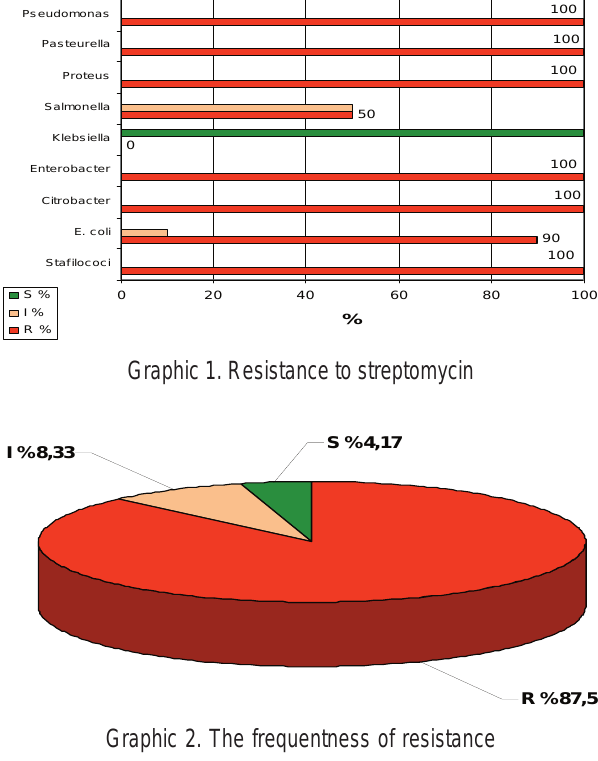
Graphic 2. The frequentness of resistance phenomenon to